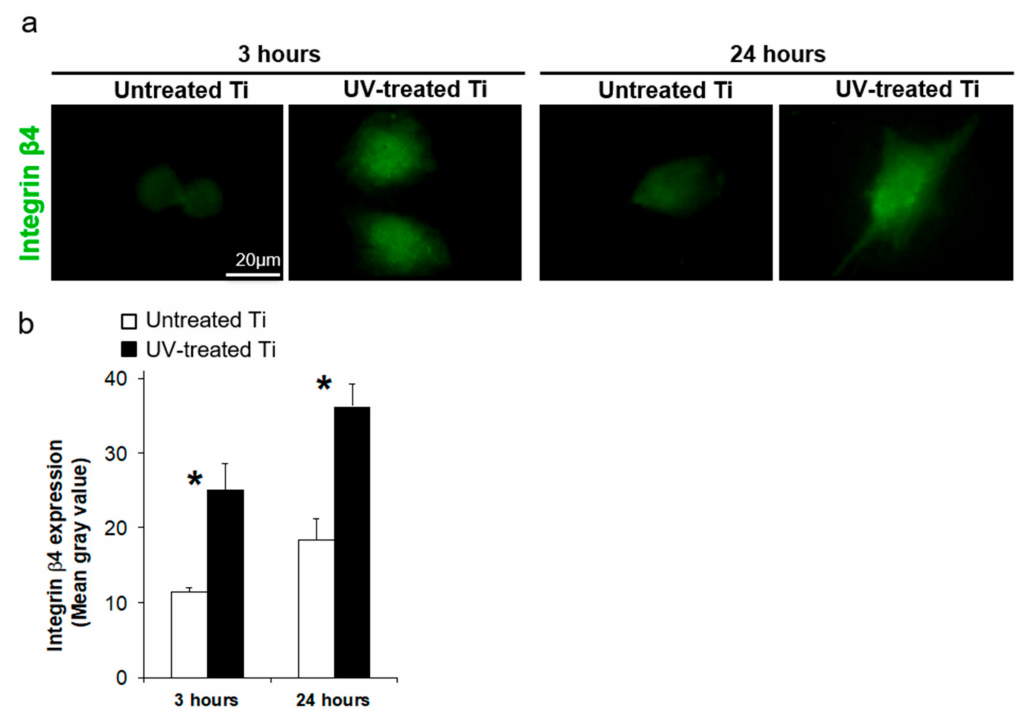
Figure 4. Protein expression of hemidesmosome-related protein, integrin β 4. ( a ) Representative images of integrin β 4 expression in cells on the untreated control and UV-treated titanium surfaces after 3 and 24 h of culture. Scale bar = 20 µ m. ( b ) The bar graph shows image-based quantification of the integrin β 4 expression (* p < 0.05).